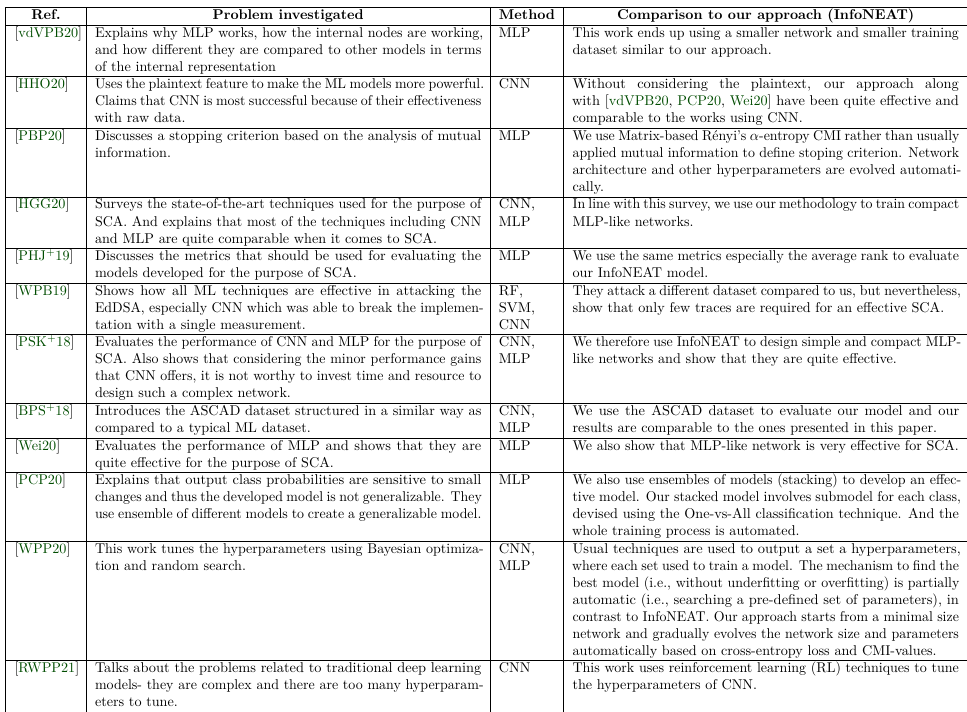
Table 7: Table showing the most recent and state-of-the-art works in the field of SCA. The table also elaborates on the problem investigated as well as the comparison to our approach, InfoNEAT. In this table, RF, SVM refer to random forest and support vector machine algorithms,